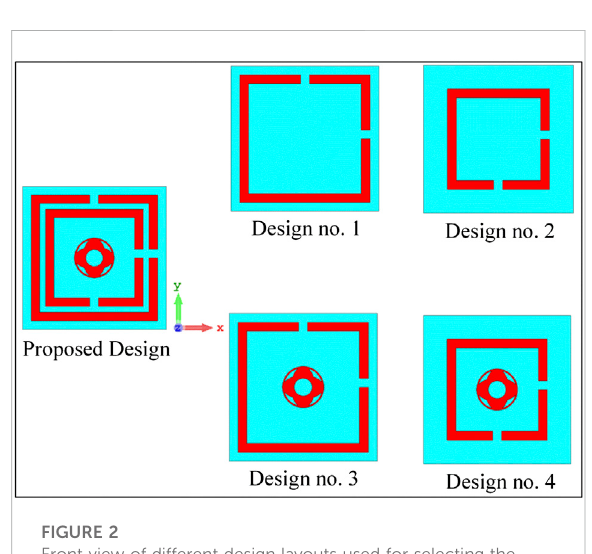
FIGURE 2 Front view of different design layouts used for selecting the fi nal